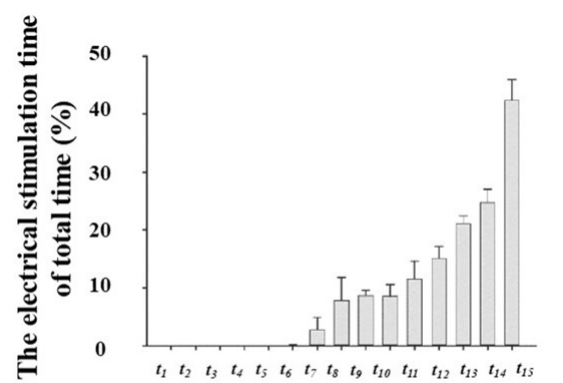
Figure 7 - Percentage of slippage time of total time by time